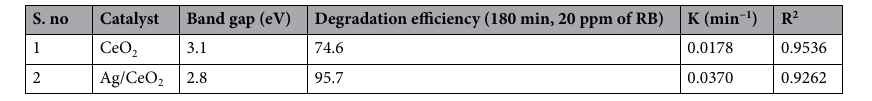
Table 1. Photocatalytic activity studies of CeO 2 and Ag decorated CeO 2 nanoparticles.